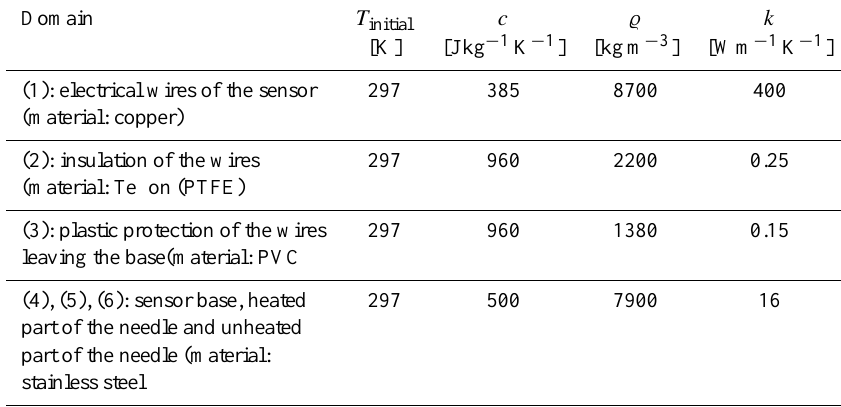
Fig. 8. Model of the TP02 sensor embedded in a sample. Table 4. Parameters used for the different domains of the